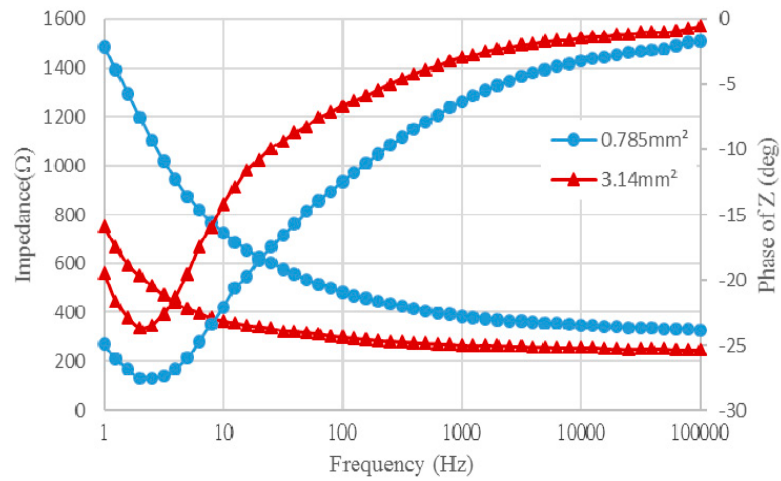
Figure 5. Impedance, phase angle and frequency of electrodes.